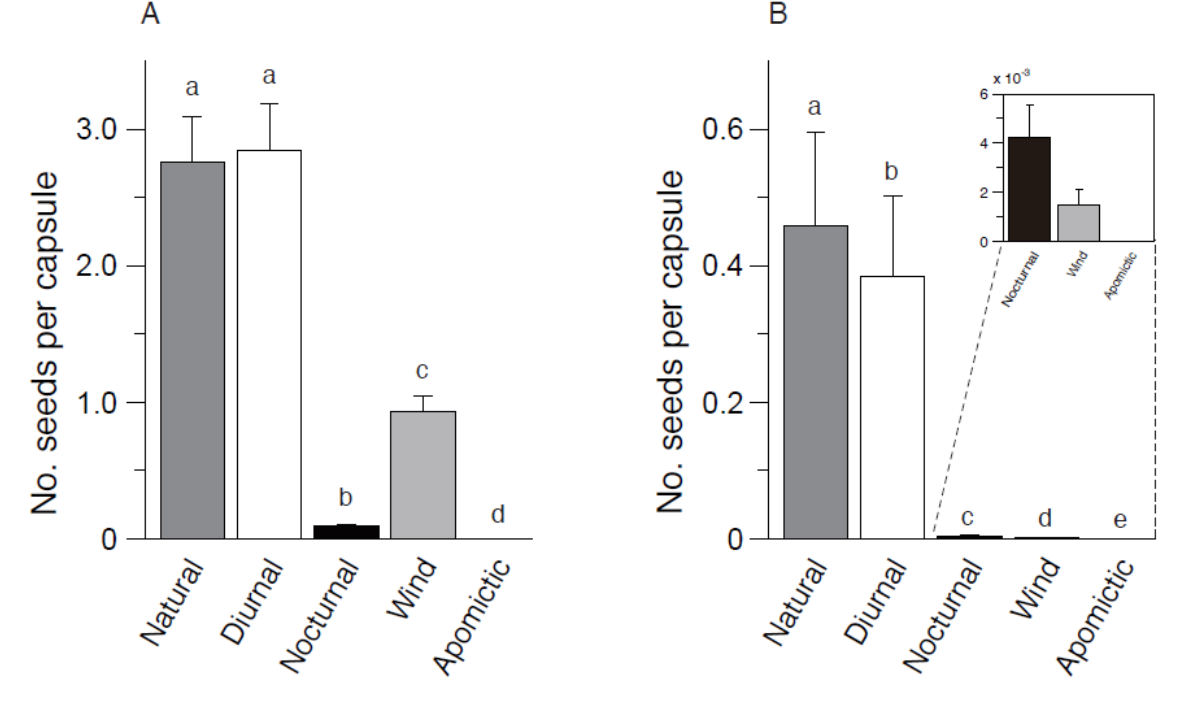
Figure 4. Seed set of Salix caprea in five pollination treatments. According to the patterns obtained, the data are divided into two groups of populations, i.e., (A) HB & OB and (B) WB & MG. Columns and bars indicate marginal (model-adjusted) means and SEs of the back-transformed proportions of seed set per capsule. The difference of means was tested for each pair of treatments. Means with shared letters are not significantly different at the 0.05 level after adjusted by Tukey correction. The inset graph magnifies the seed set axis to highlight the difference between nocturnal and wind